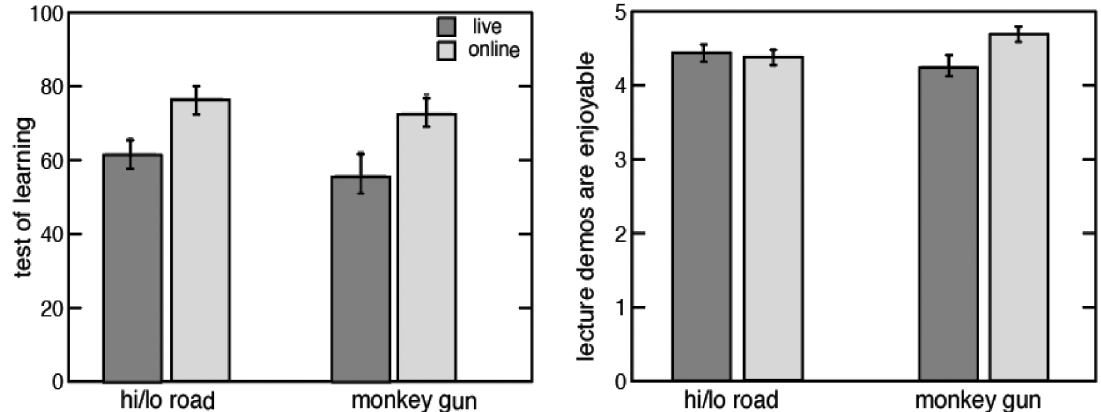
FIG. 1. Performance on the postdemo test of learning and level of enjoyment for students in the live group (dark gray) vs the online video group (light gray) for both the High Road, Low Road and Shoot the Monkey demos. Error bars represent 1